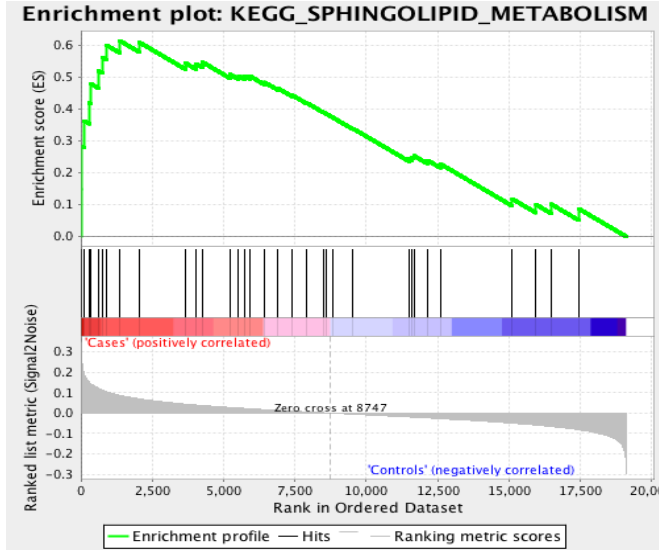
Figure 6. Enrichment plot for the sphingolipid metabolism pathway for ITG RNA-seq dataset based on case and control phenotypes and enriched using the KEGG biological pathway database.